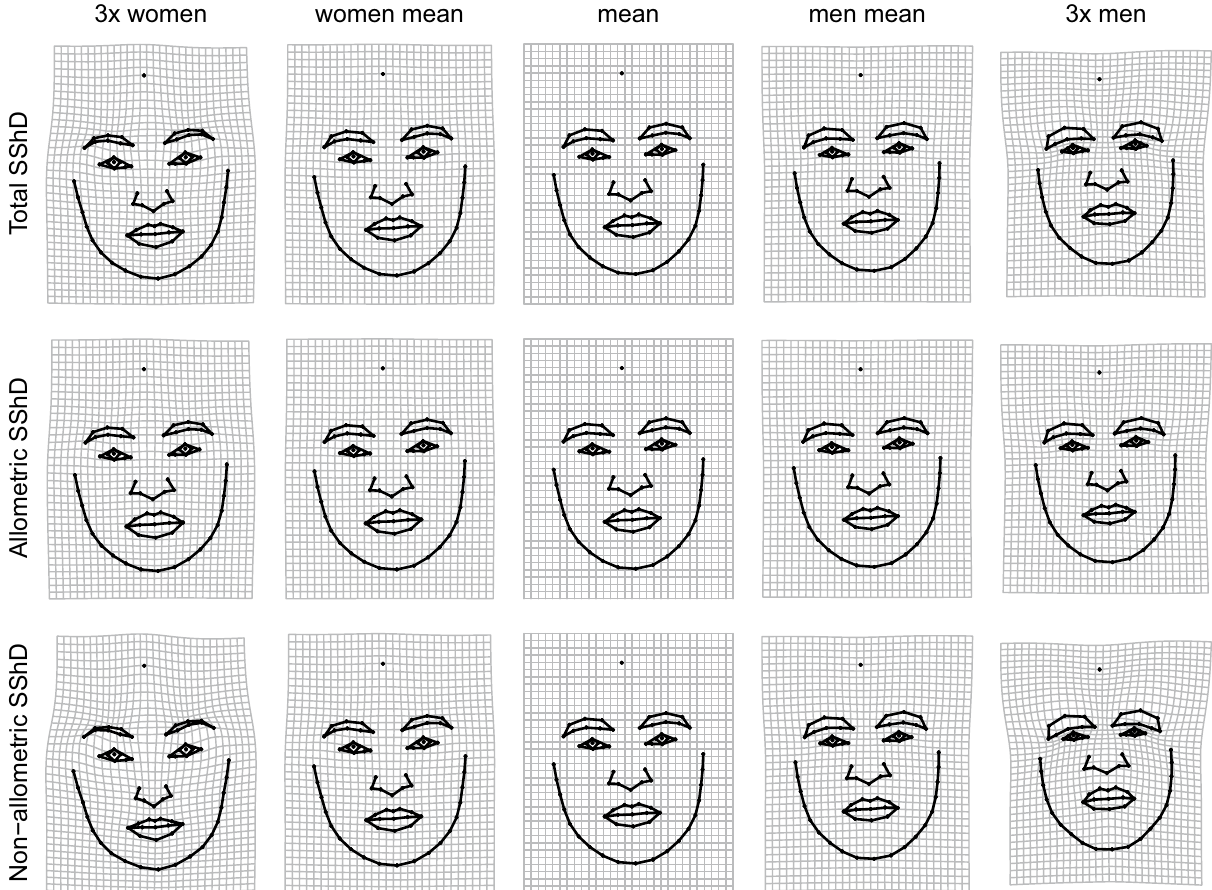
Figure 4. Thin-plate spline visualizations of facial shape variation associated with differences between sexes and its decomposition to allometric and non-allometric components. Thin-plate splines are shown within observed range and 3 × extrapolated compared to an average configuration in the